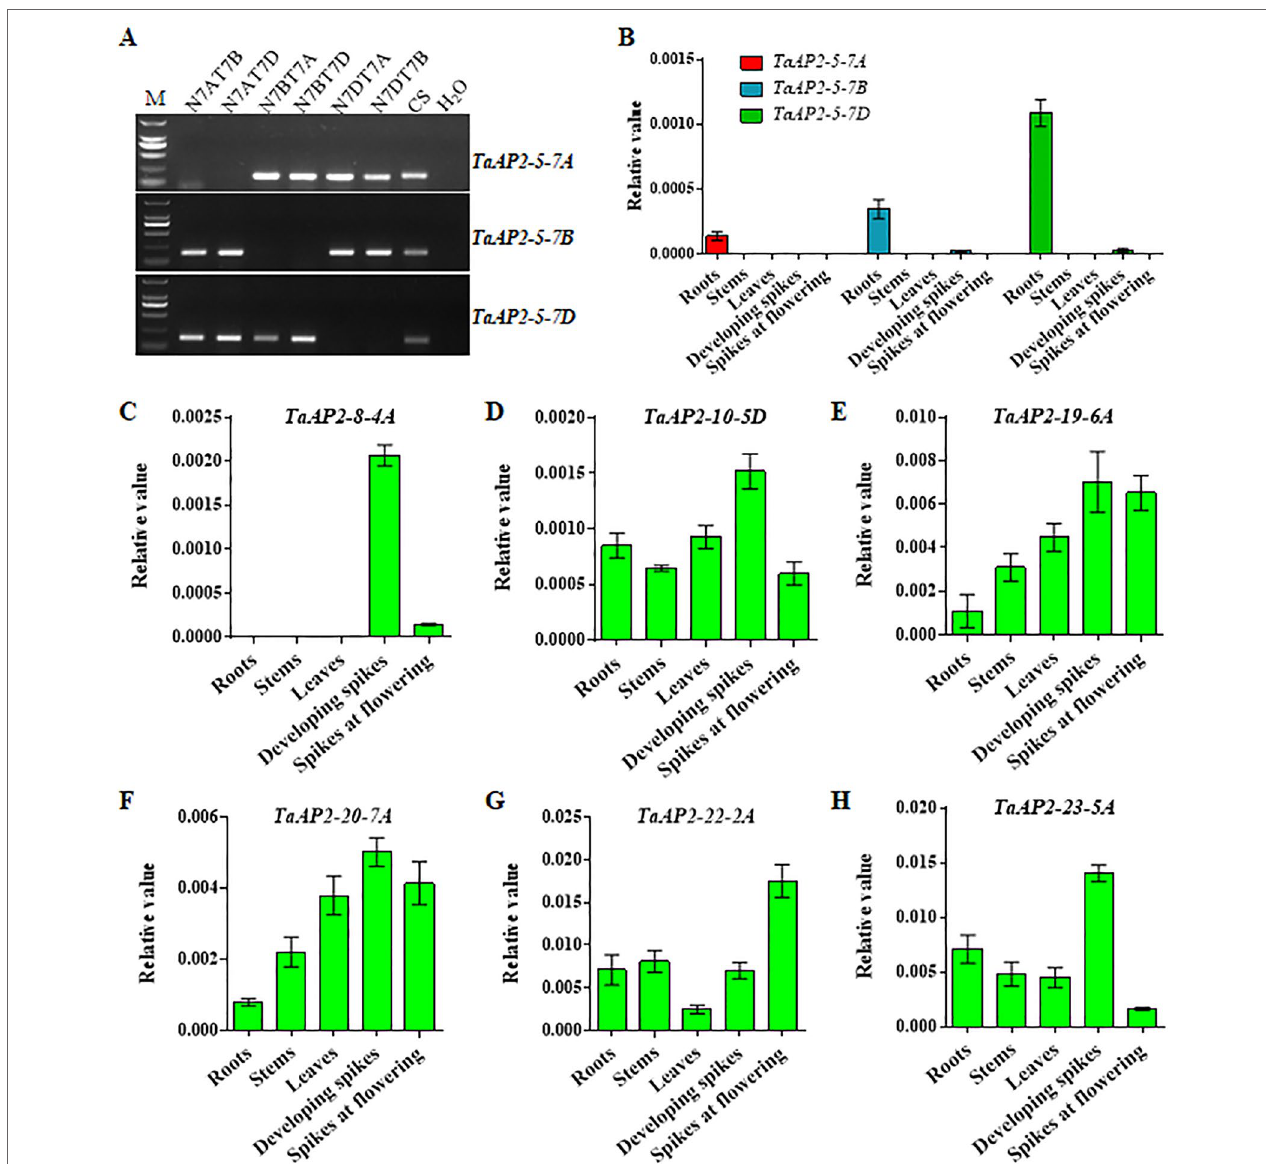
FIGURE 5 | QPCR verification of the expression levels of several TaAP2 genes in different wheat tissues, including roots, stems, leaves, developing spikes, and spikes at flowering. (A) Verification of the sub-genome specificity of primer pairs for TaAP2-5 genes in Chinese Spring nullisomic/tetrasomic (NT) lines. (B) Expression levels of TaAP2-5A , TaAP2-5B, and TaAP2-5D revealed by qPCR. (C – H) Expression levels of TaAP2-8-4A (C) , TaAP2-10-5D (D) , TaAP2-19-6A (E) , TaAP2-20-7A (F) , TaAP2-22-2A (G) , and TaAP2-23-5A (H) revealed by qPCR. Data were normalized by the wheat β -actin gene using the 2 −ΔCt method. Bars indicate standard deviations of three biological